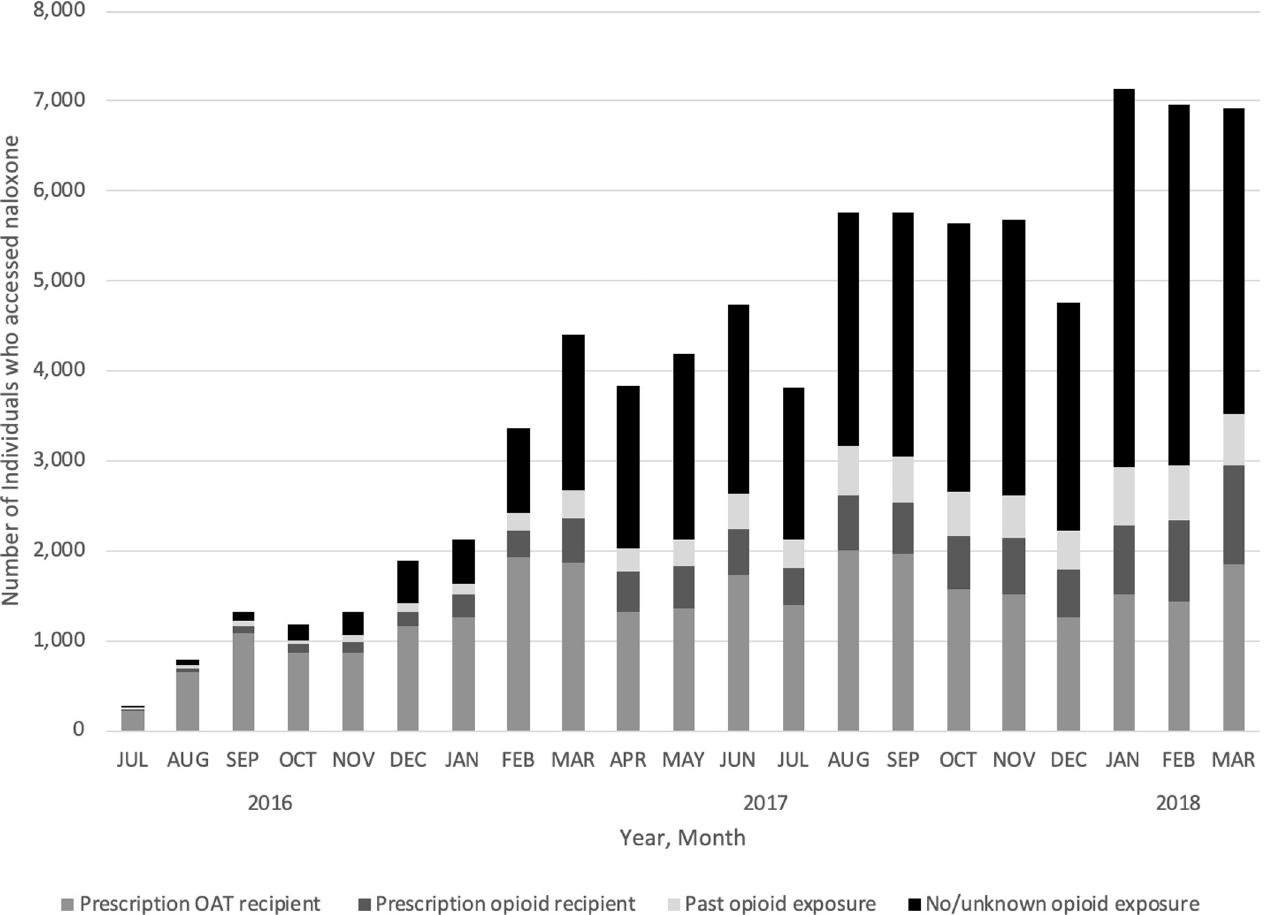
Fig 2. Monthly number of individuals who accessed naloxone between July 2016 and March 2018, stratified by opioid exposure group.